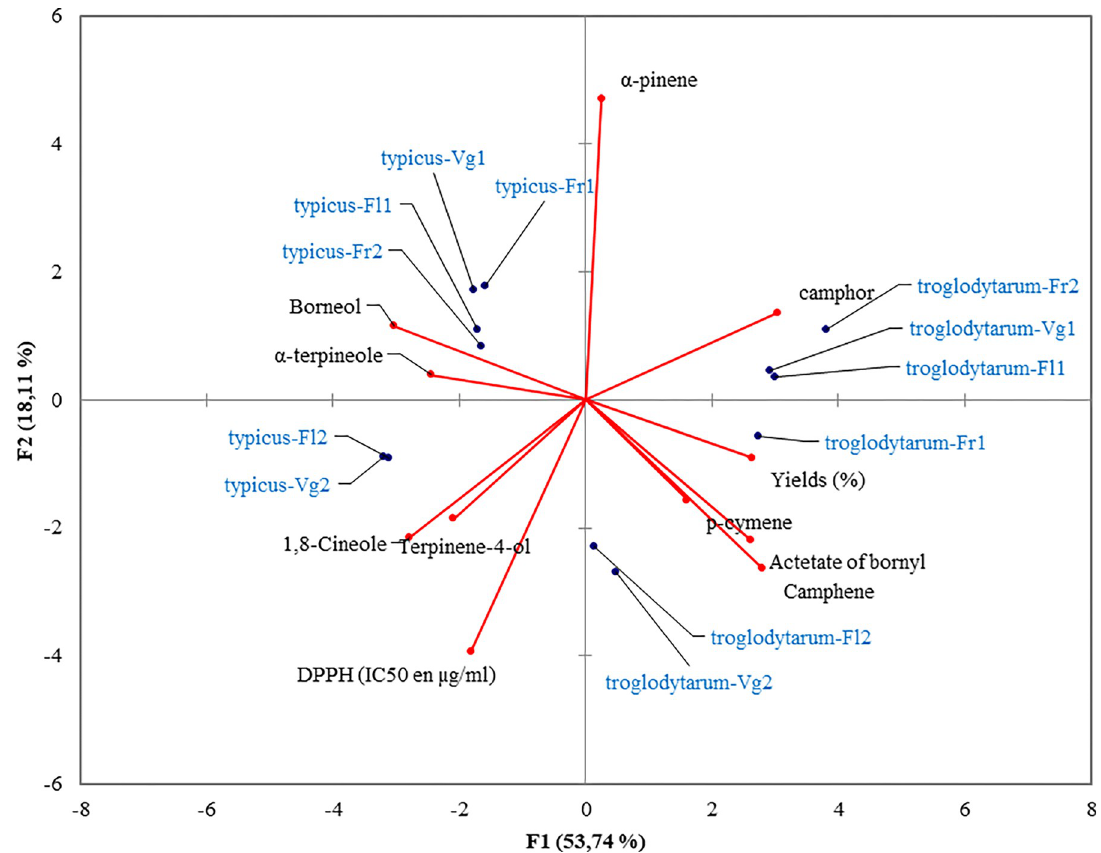
Fig 4. Principal component analysis plot of Rosmary samples and essential oil compounds.